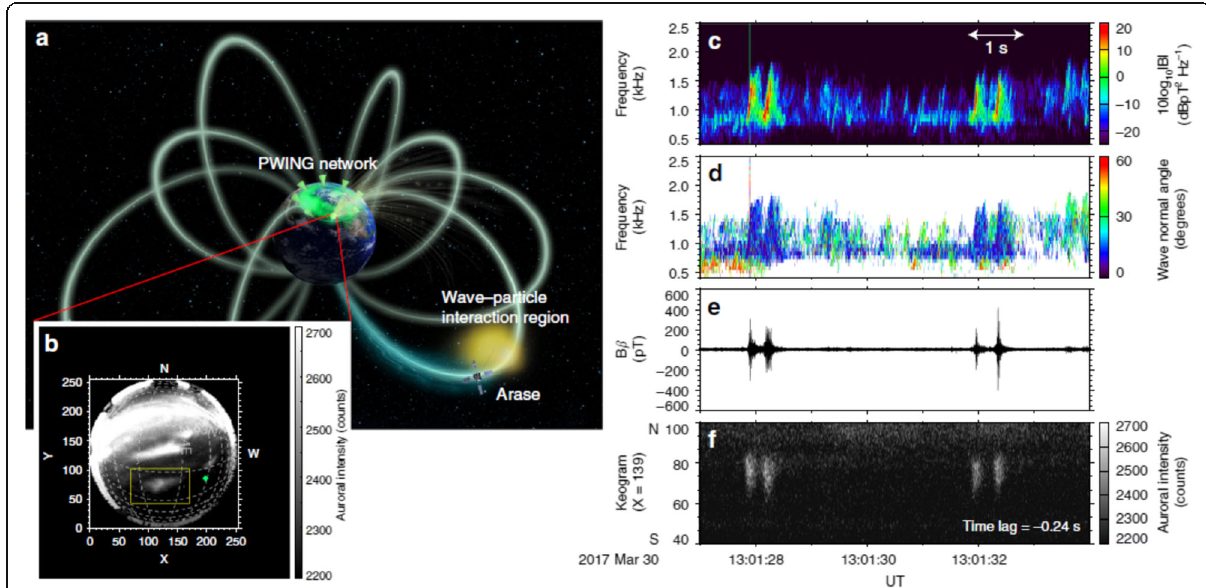
Fig. 12 Coordinated ground and ERG (Arase) observations. a Illustration of conjugate observations from the ground network of the PWING project and the ERG satellite. Earth in panel a is mapped using NASA image. All rights reserved. b All-sky EMCCD snapshot observed at Gakona in Alaska at 13:01:28 UT, 30 March 2017. Dotted lines indicate the spacing of geographical latitudes and longitudes at 1° and 2° intervals. The yellow frame indicates the auroral region that is focused on in this study. The green diamond symbol indicates ERG ’ s footprint at the time of observation. c , e The dynamic spectrum, wave-normal angle with respect to the geomagnetic field line, and the waveform of large-amplitude chorus elements observed by ERG near the magnetic equator. f North to South cross-section (keogram) of auroral emissions with a time shift of − 0.24 s (taken from Ozaki et al.